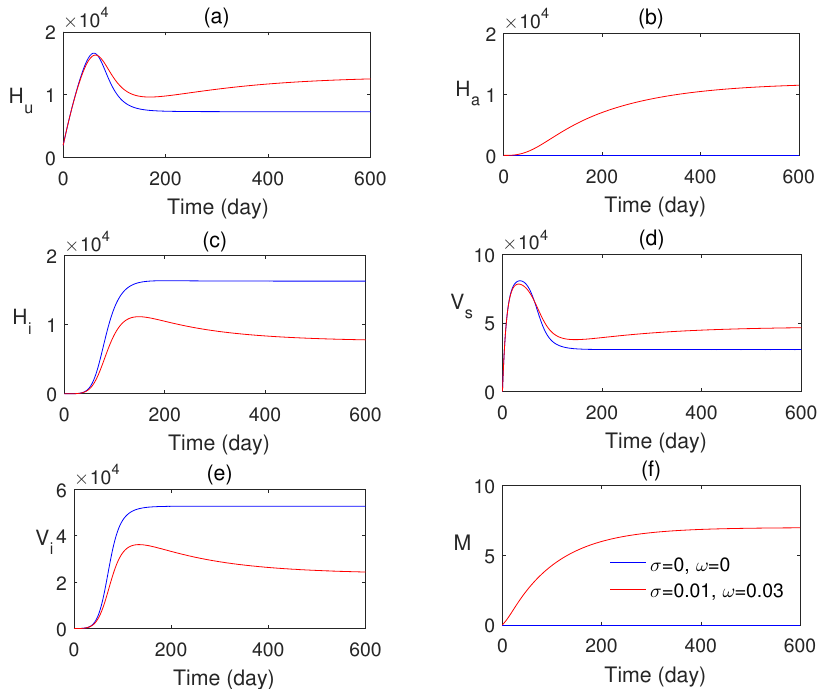
Figure 3. Numerical solution of system (1) with and without the impact of awareness.